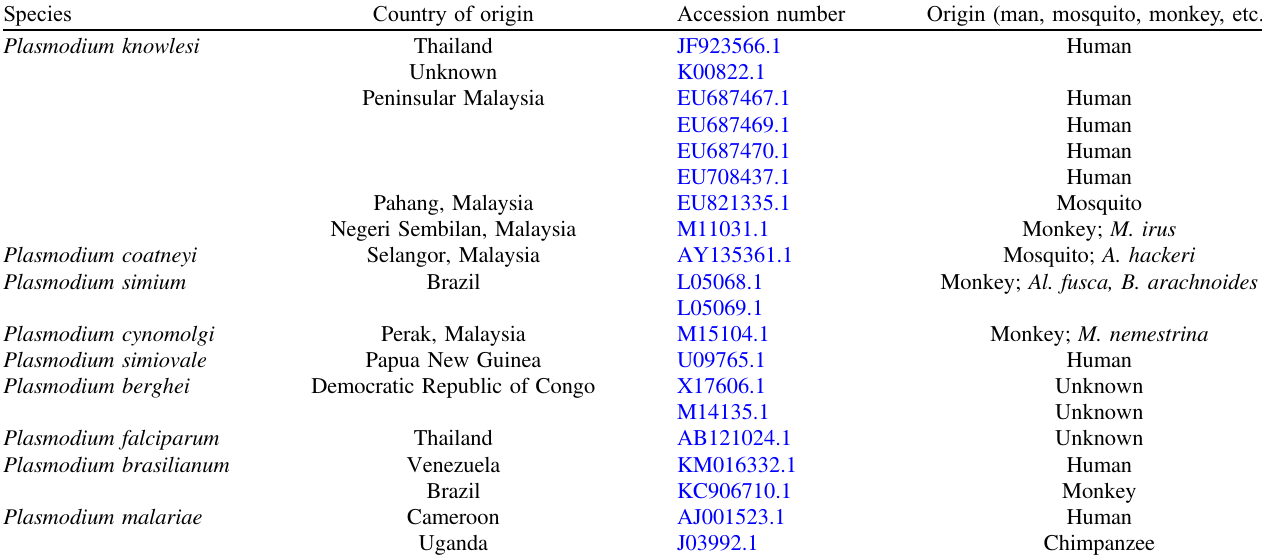
Table 3. Reference sequence obtained from GenBank used in phylogenetic analysis.